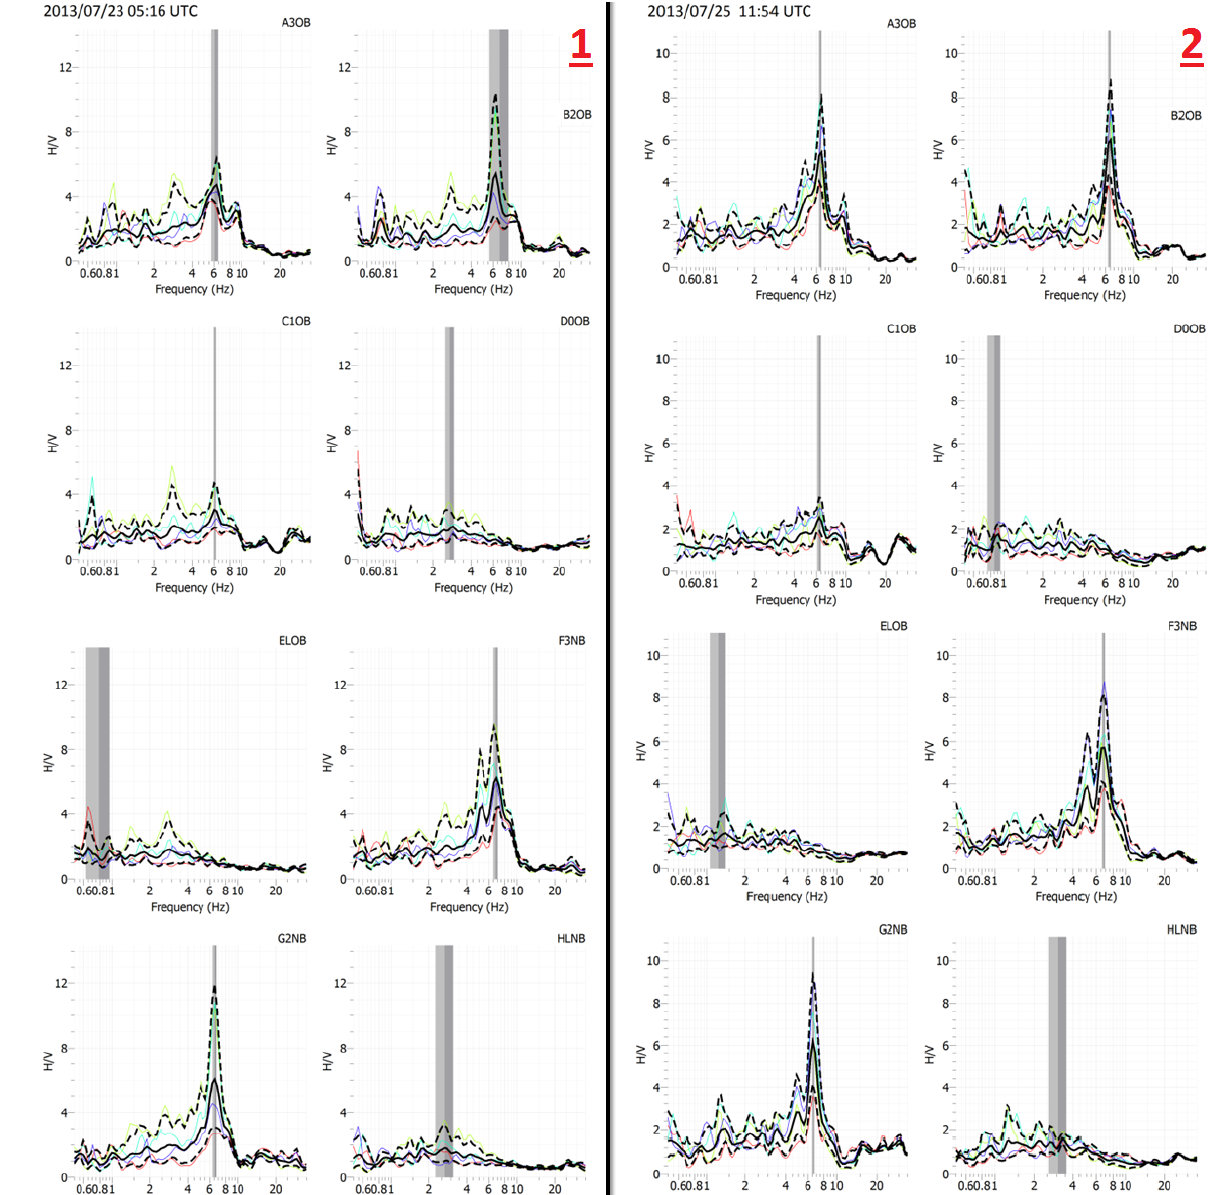
Figure 13. HVSR analysis of seismic events with code names 1 (left) and 2